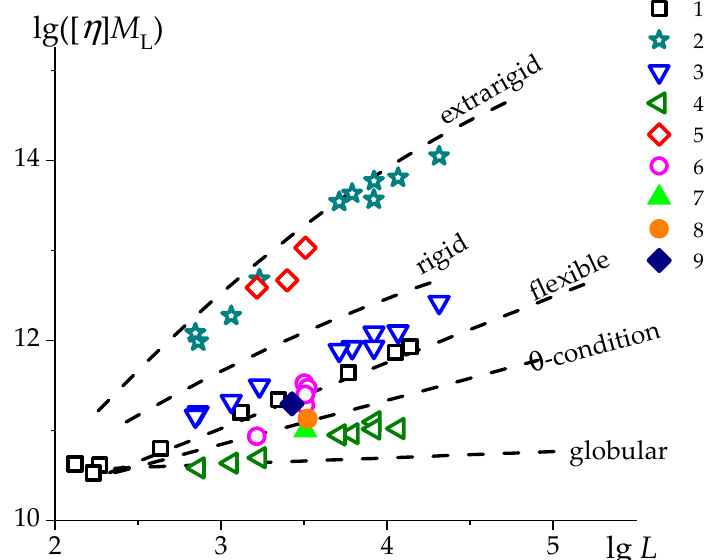
Figure 9. Normalized Kuhn-Mark-Houwink-Sakurada dependencies, (i.e., dependences of [ η ] M L characterizing the volume occupied by a chain segment corresponding to unit contour length of the macromolecule on the contour length of the macromolecule ( M / M L ) in a double-logarithmic scale) for PMVA ( M L = 393 g/mol nm) [57] in H 2 O (1); PSSNa ( M L = 750 g/mol nm) [54,59] in different aqueous compositions: H 2 O (2), 0.2 M NaCl (3), 4.17 M NaCl (4); MVAA- co -MVAC 12 H 25 ( M L = 468 g/mol nm) [55] in H 2 O (5), in aqueous 0.1 M NaCl (6), 1 M NaCl (7), and 1.6 M NaCl (8) solutions; MVAA- co -MVAC 10 H 21 ( M L = 452 g/mol nm) in aqueous 2 M NaCl solution (9). Dashed lines correspond to different conformations of linear chains: extra-rigid, rigid, flexible, globular, and θ -conditions [72,73] .